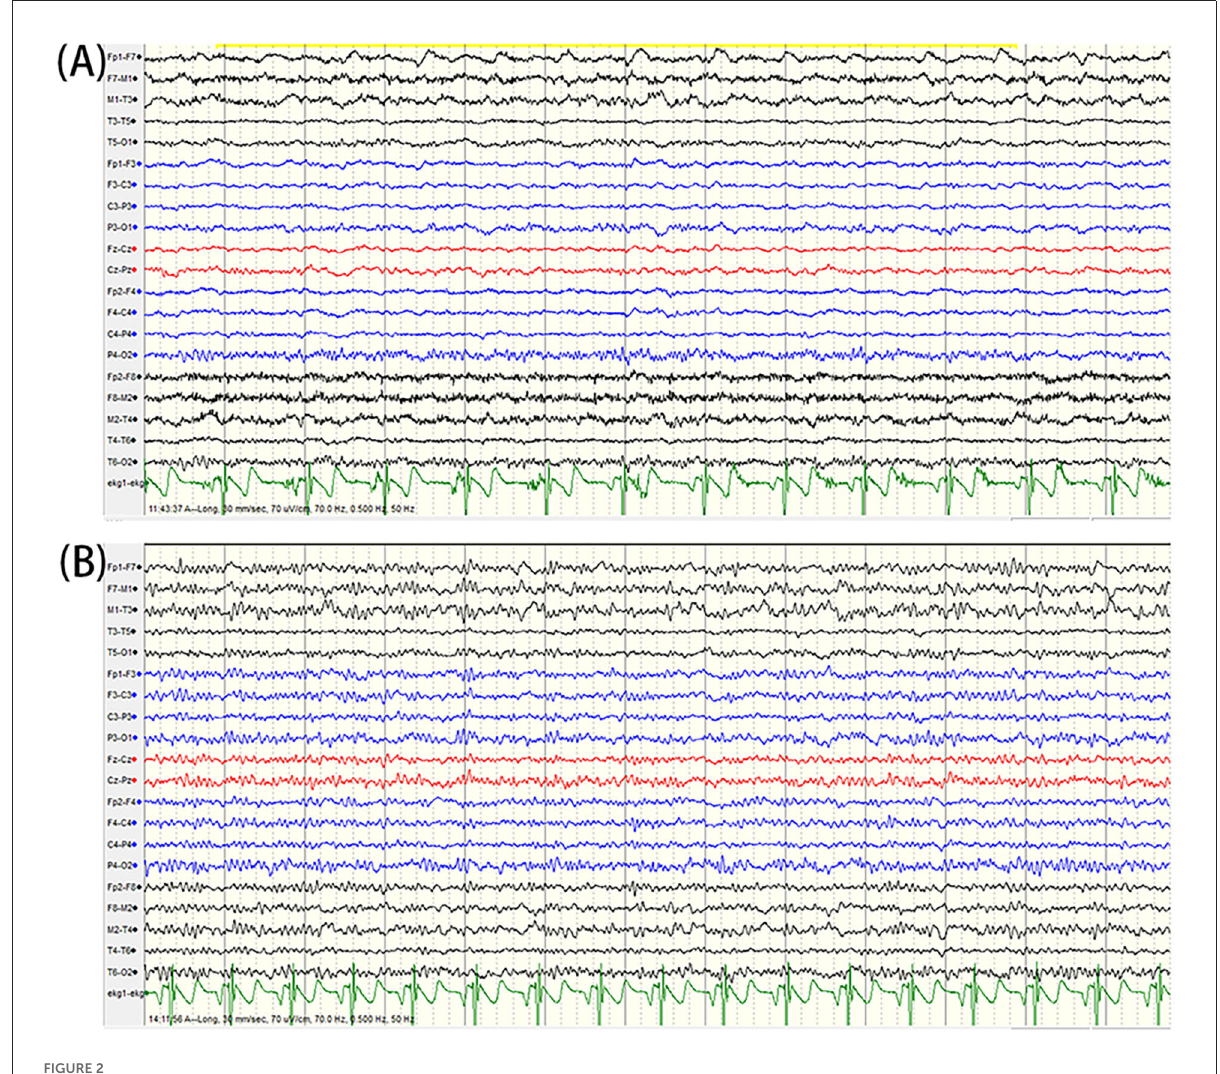
FIGURE2 EEG manifestations at the time of right arm paroxysmal clonus occurrence (A) and after intravenous midazolam (B)